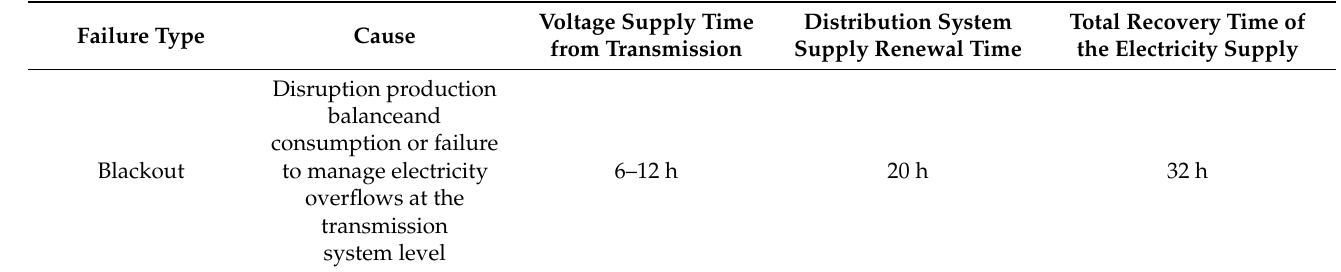
Table 1. Basic parameters of the scenario for the restoration of the power supply after a large-scale power supply failure [19].